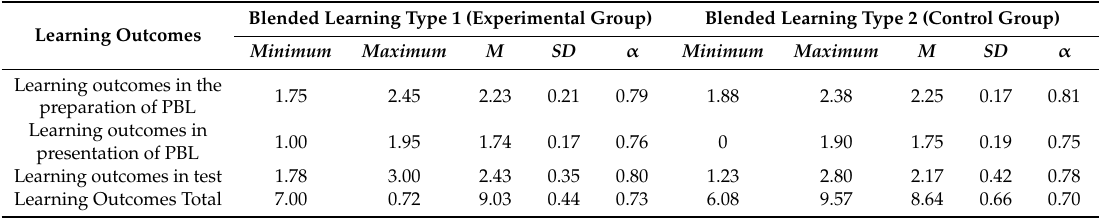
Table A1. Descriptive statistics for the Learning outcomes.